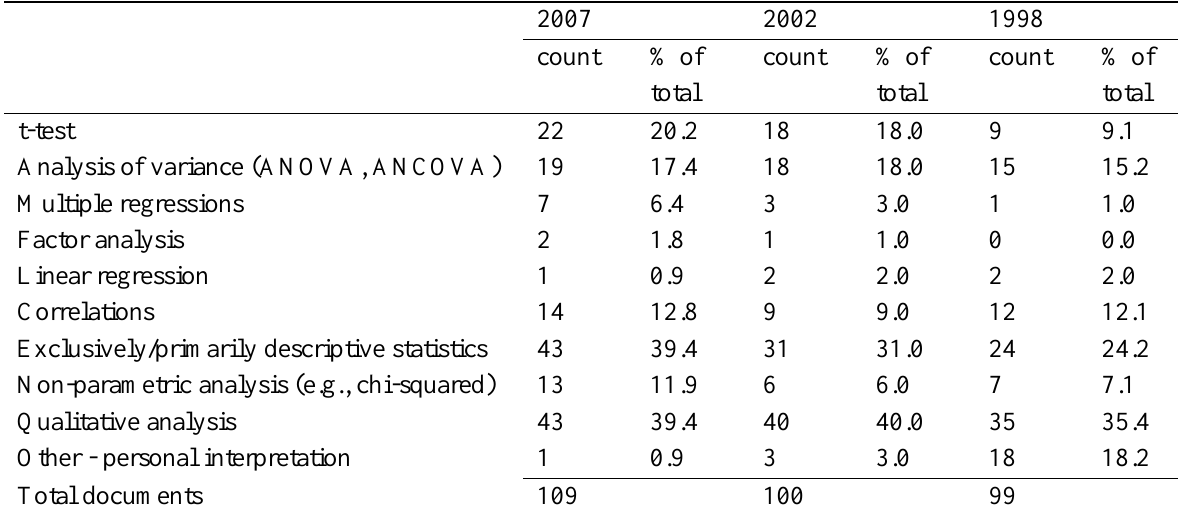
Data Analysis Technique Distribution by